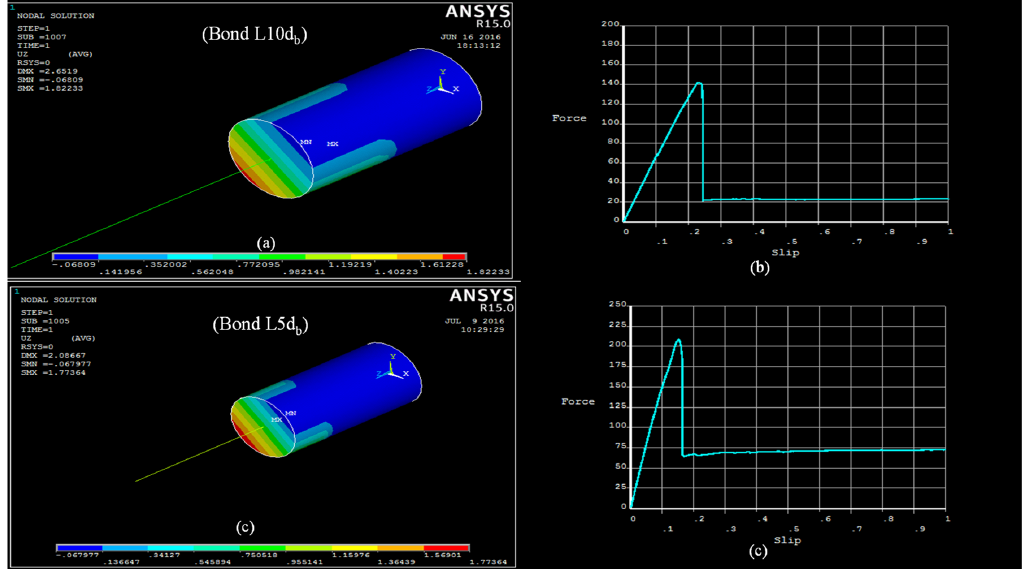
Figure 10. Stress of #19 diameter bar at failure and generated curves ( a , b ) for bond10 d b , ( c , d ) for bond5 d b .